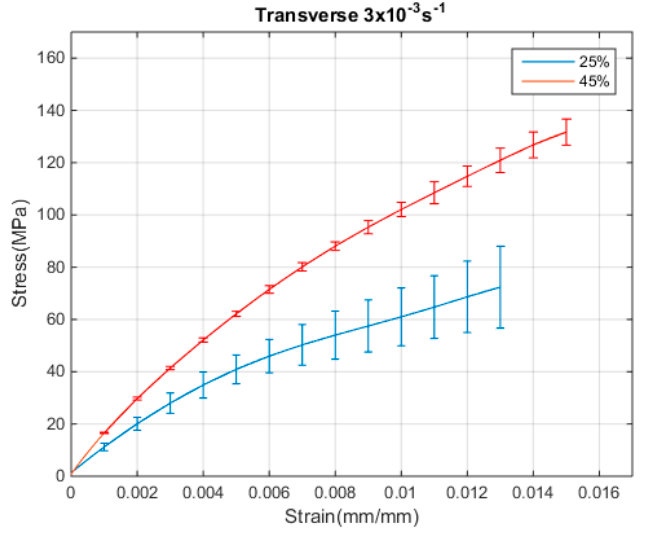
Figure A2. Transverse 25% and 45% 3 × 10 − 3 s − 1 Results with Standard Deviation Error Bars.